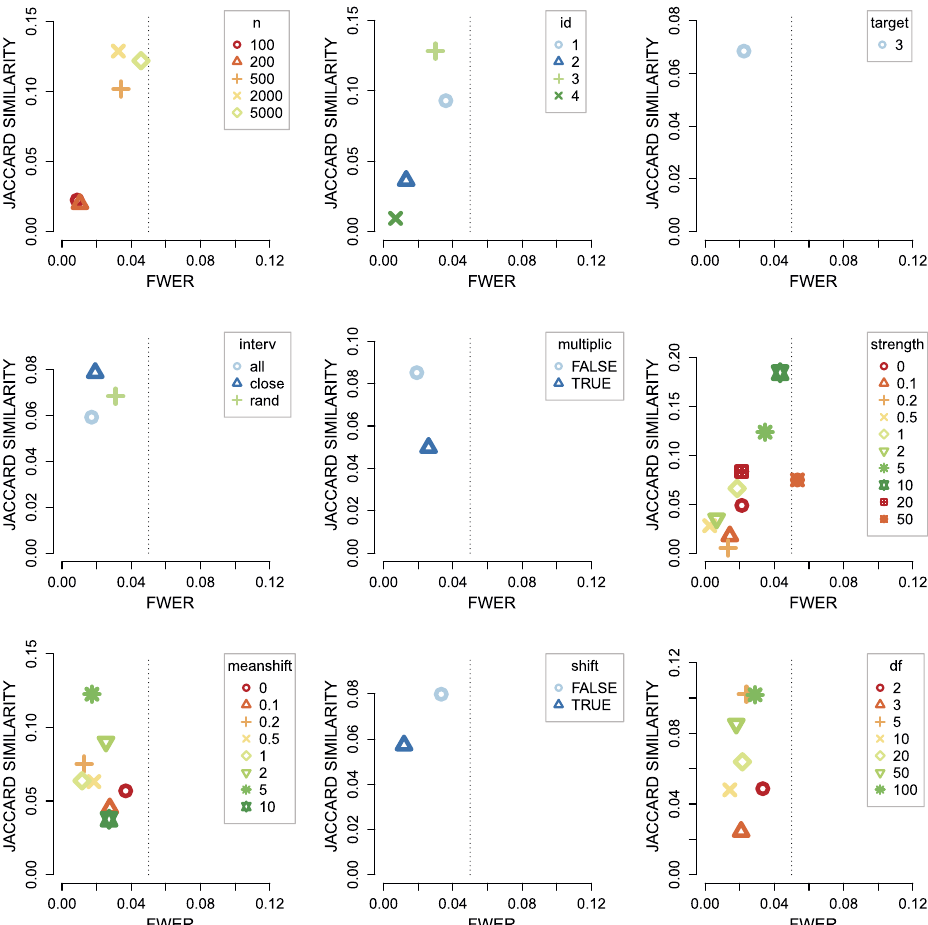
Figure 11: Average Jaccard similarity over the conditional independence tests (A)–(F) (y-axis) against average FWER (x-axis) when estimating the parents of variable 3. The figure is otherwise generated analogously to Figure